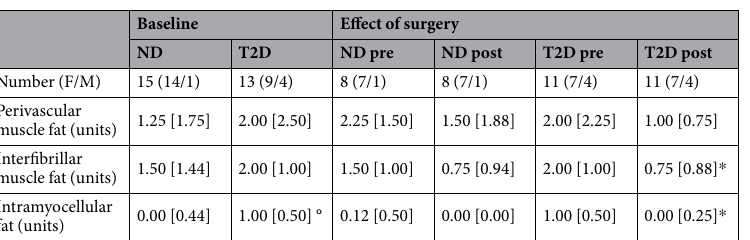
Table 1. Baseline anthropometric and metabolic parameters in nondiabetic (ND) and diabetic (T2D) surgical patients and in non-obese control subjects (Ctrls) § . § Entries are mean ± SEM or median [interquartile range]; BMI = body mass index; FM = fat mass; NEFA = nonesterified fatty acids; MCP-1 = monocyte chemoattractant protein; IL-6 = interleukin-6; TNF α = tumor necrosis factor- α ; M/I = insulin-mediated glucose disposal rate; RaGly = glycerol rate of appearance; AT-IR = adipose tissue insulin resistance index; Mean Glucose = calculated from the glucose AUC during MTT; ß-GS = beta-cell glucose sensitivity; ISR = insulin secretion rate; nd = not determined. * T2D vs ND by Mann Whitney test. °p ≤ 0.05 for the difference between controls (Ctrls) and the combined ND and T2D group.